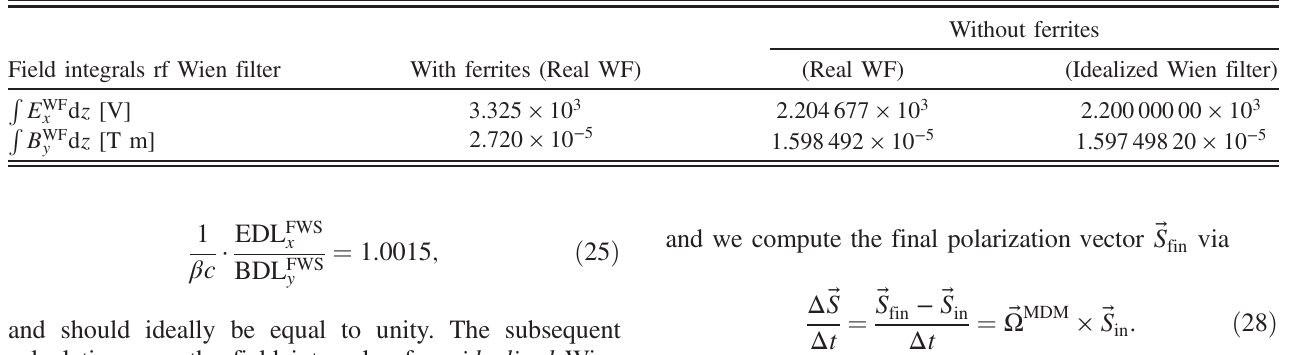
R R R R E WF E WF B WF B WF d z ¼ d z ¼ d z ¼ d z ¼ 0 y z x z